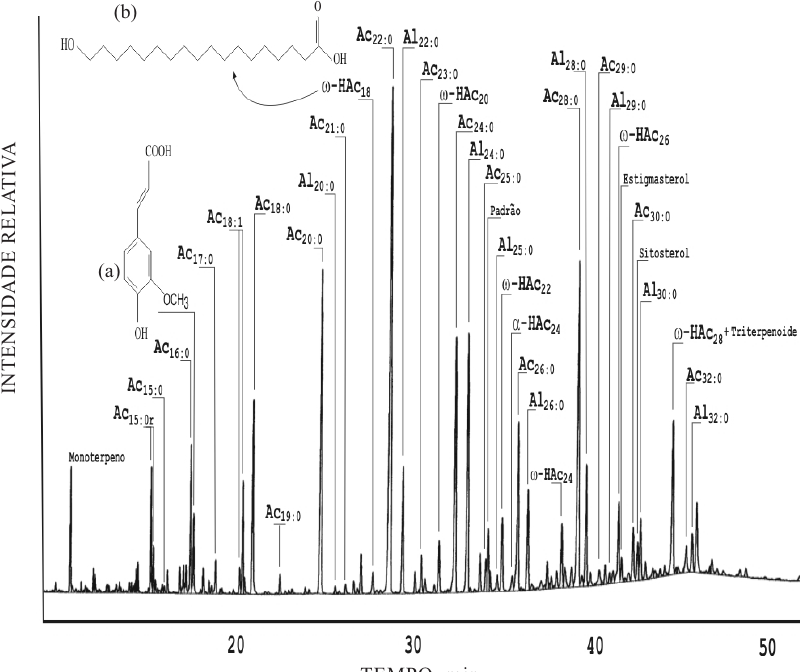
Figura 3. Cromatograma parcial da amostra de sedimento obtida no contexto QQ21/N3 do Sítio Arqueológico Rio do Meio, Ilha de Santa Catarina, SC. Em destaque as estruturas de um derivado do ácido cinâmico (a) e de um ωωωωω -hidroxiácido (b). Ac e Al , respectivamente ácidos e álcoois; x, número de átomos de x:y x:y carbono; y, número de insaturações; ωωωωω -HAc , hidroxiácidos com a hidroxila na posição ωωωωω ; padrão, x 5 ααααα